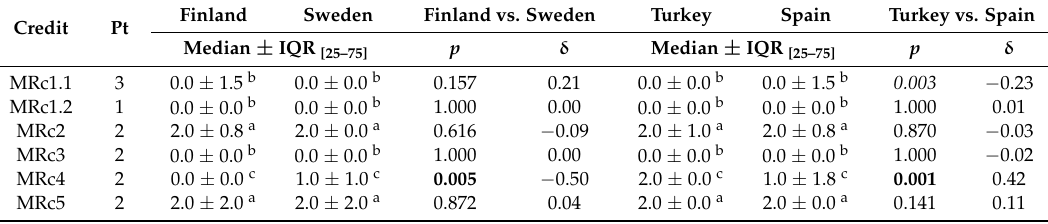
Table 6. MR achievement: Northern European countries vs southern European countries.